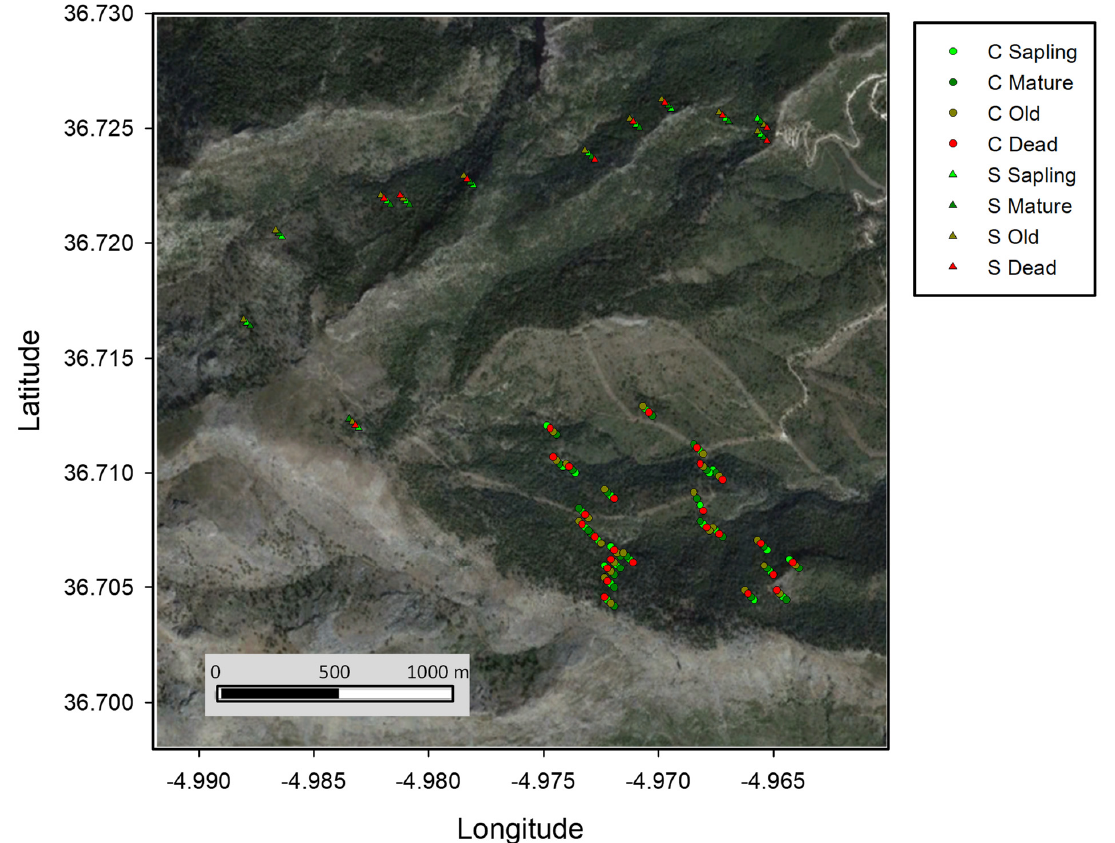
Figure 1. Sampling location of the Abies pinsapo individuals analyzed in this study. Age/survival individual groups are represented by different colours for Saucillo (S, triangles) and Caucon (C, circles) populations. Background satellite image was obtained from Landsat (July 2018).